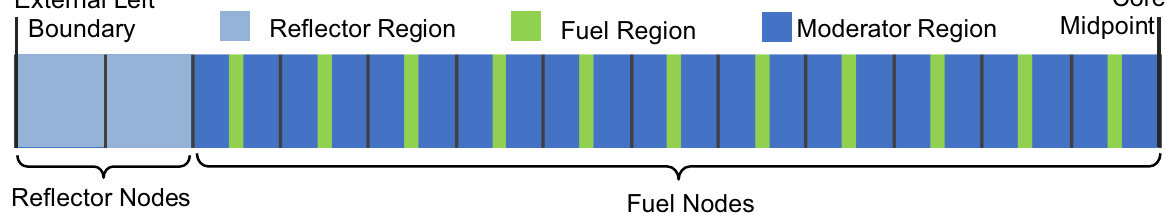
Figure 2. One-dimensional Heterogenous-Node PHWR Model (Half-core Representation) Each node in Fig. 2 spans 28.575 cm and within the fuel nodes the width of the fuel region is such that the ratio of the length of the fuel region to that of the entire fuel node in the 1D model is equal to the ratio of obtained from DRAGON and used in the 1D, 2G PHWR model are presented in Table I in which Σ (cid:3)(cid:4) and Σ (cid:3)(cid:5) represent the group 1 and 2 macroscopic neutron absorption cross sections, (cid:6)Σ (cid:7)(cid:4) and (cid:6)Σ (cid:7)(cid:5) represent the group 1 and 2 macroscopic neutron production cross sections, Σ (cid:8)(cid:4)→(cid:5) represents the macroscopic cross section for down-scattering from group 1 to 2, Σ (cid:8)(cid:5)→(cid:4) represents the macroscopic cross section for up- scattering from group 2 to 1, and (cid:10) (cid:4) and (cid:10) (cid:5) represent the group 1 and 2 diffusion coefficients. Table I. Nuclear Parameters of the Heterogeneous PHWR Model under Cooled